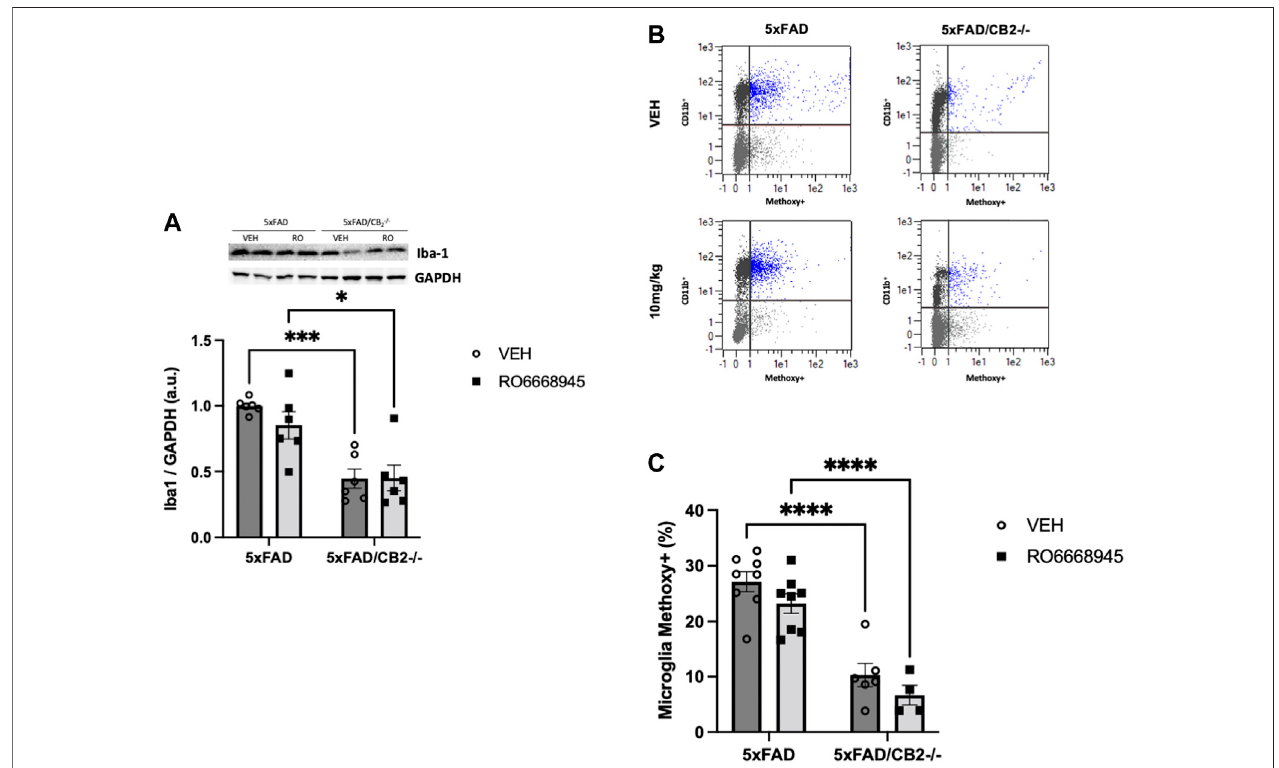
FIGURE5| Iba1+microgliaandphagocyticactivityisdecreasedaftergeneticdeletionofthecannabinoidCB 2 receptor.Analysisofcorticesbywesternblot (A) and fl ow cytometry (B,C) revealed no changes associated to the treatment with the agonist together with a signi fi cant decrease in Iba1+ microglia (A) . Phagocytic activity (B,C) of microglia was signi fi cantly impaired in 5xFAD/CB 2-/- mice. Scatter plots of CD11b isolated microglia after intraperitoneal administration of methoxy-X04 are shown (B) . Phagocytic capacity was calculated as percentage of methoxy-X04+/CD11b+/CD45lo cells to CD11b+/CD45lo cells (C) . Two-way ANOVA followed by Tukey ’ s post-hoc test. * < p 0.05. ** < p 0.01; *** < p 0.001; **** < p 0.0001. N = 5 – 6 mice per group. Data represent mean ±